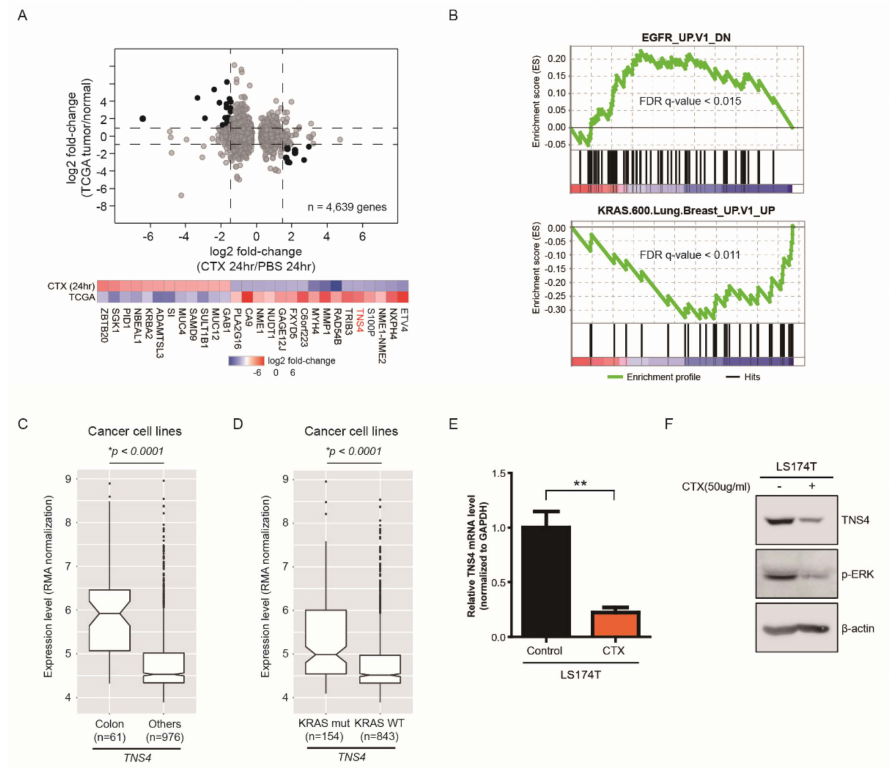
Figure 1. Identification of a subset of genes significantly regulated by cetuximab treatment through whole genome expression analysis. ( A ) Expression level of genes (FDR-adjusted p -value < 0.05) in cetuximab (CTX)-treated and PBS-treated xenograft mouse tumor with KRAS G12D mutation-bearing LS174T cells were compared with the expression levels of genes in the COADREAD obtained from the cancer genome atlas (TCGA) database. The fold change of (CTX-treated / PBS-treated) or (tumor / normal) is shown in log2 in graph. ( B ) Gene set enrichment analysis (GSEA) for common biological function of EGFR or KRAS associated pathway in CTX treated LS174T cells is shown. ( C , D ) Box plots indicate the expression level of TNS4 in colon (n = 61) or other cancer cell lines (n = 976) ( C ) and in KRAS mutated (n = 154) or wild-type cell lines (n = 843) ( D ). p -value was calculated using the Mann-Whitney U test. ( E ) Quantitative PCR analysis was performed using primer sets targeting TNS4 on total mRNA isolated from LS174T cells treated with either PBS (control) or CTX. The bar graphs show the relative TNS4 mRNA levels for CTX-treated samples were normalized to control (**, p < 0.01). ( F ) LS174T cells were incubated for 24 h with or without cetuximab and the resulting cell lysates were subjected to immunoblotting with antibodies against TNS4 and phospho-ERK. β -actin was used as loading